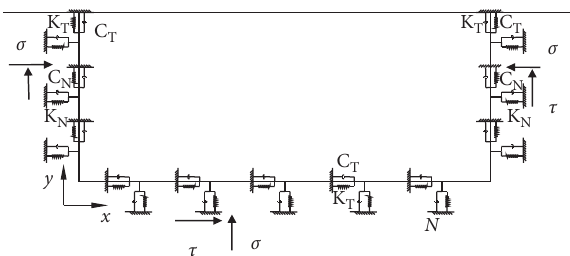
Figure 1: Massed foundation model with viscoelastic boundary [13].